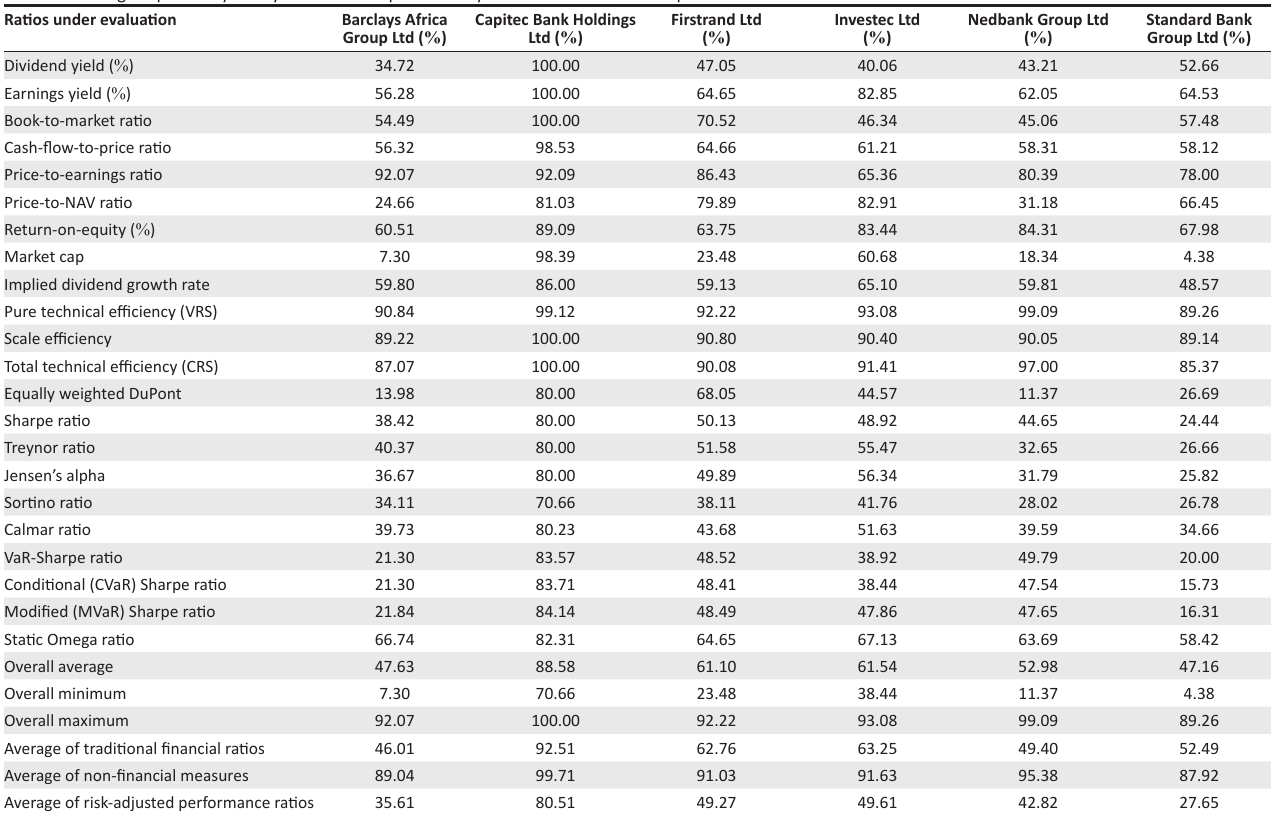
TABLE 6: Average explanatory ability of ratios to explain three years ahead share returns per